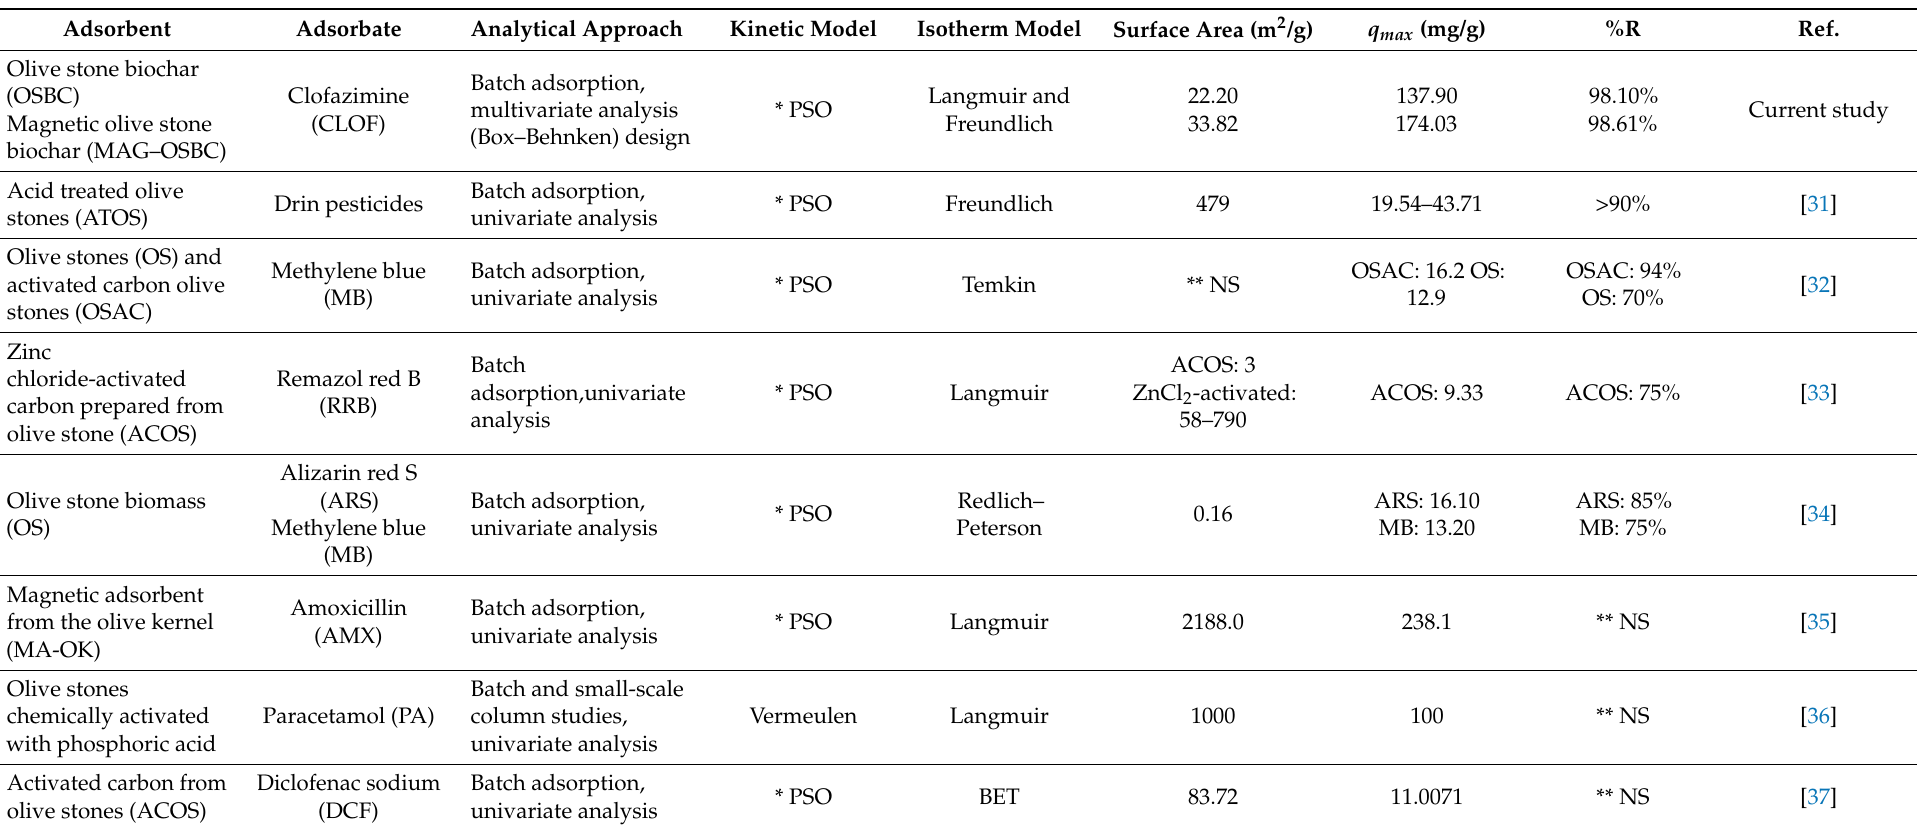
Table 1. Reported applications of the biochars obtained from olive stones for the removal of pharmaceutically active compounds (PhACs) and other